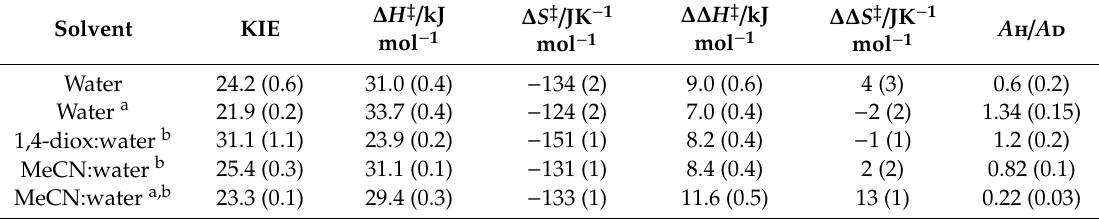
Table 1. Kinetic isotope e ff ects, activation parameters ∆ H ‡ and ∆ S ‡ , isotopic di ff erences ∆∆ H ‡ (D,H) and ∆∆ S ‡ (D,H) and ratios A h / A d in the reaction of ascorbate with TEMPO radical. Adapted from [17,18].